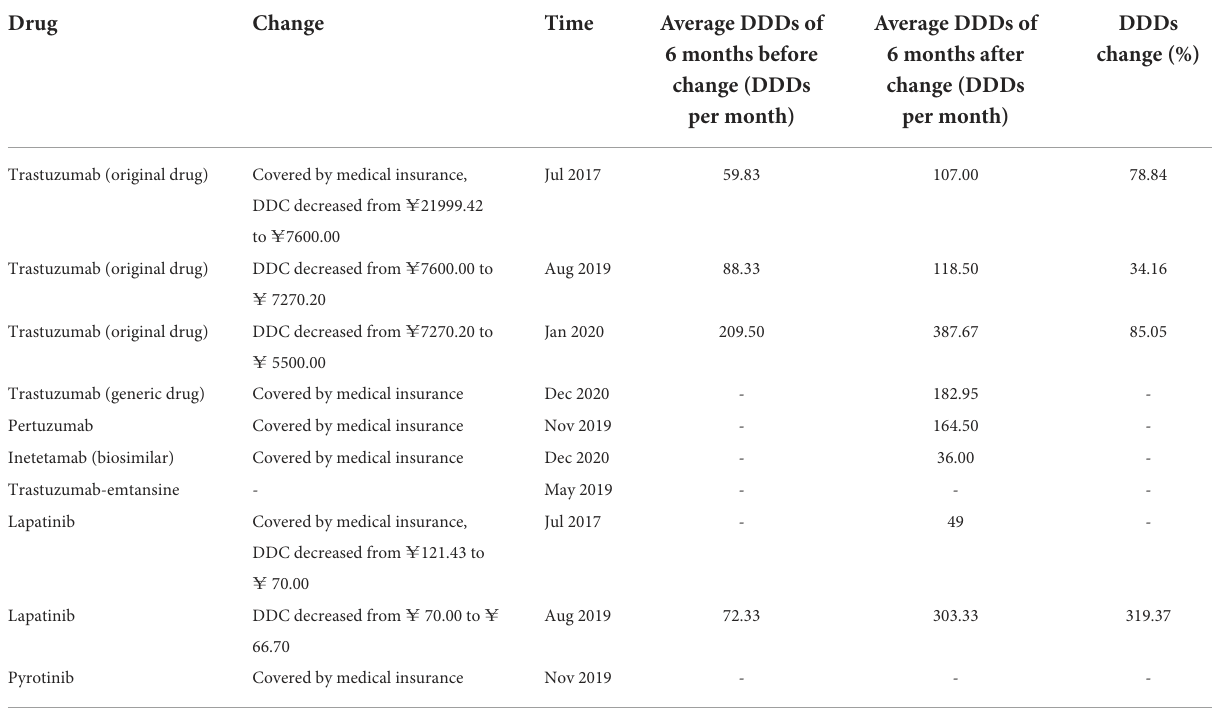
TABLE 2 The influence of insurance and price on drug